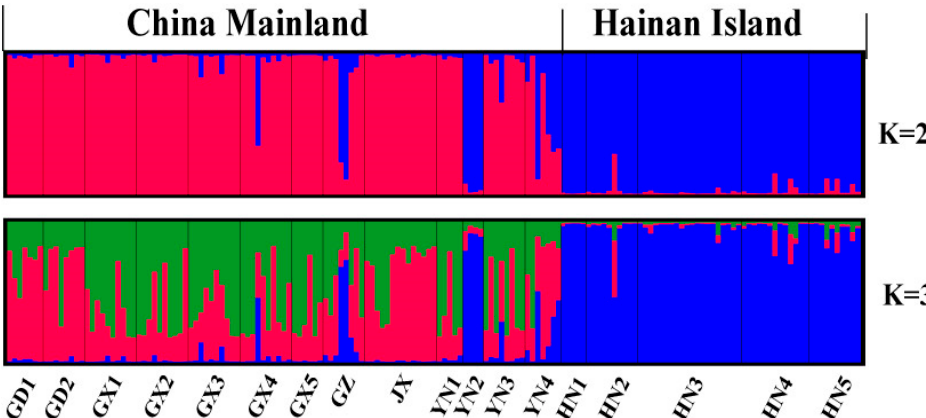
Figure 2. Bayesian phylogenetic tree generated from concatenated mitochondrial cytb and control